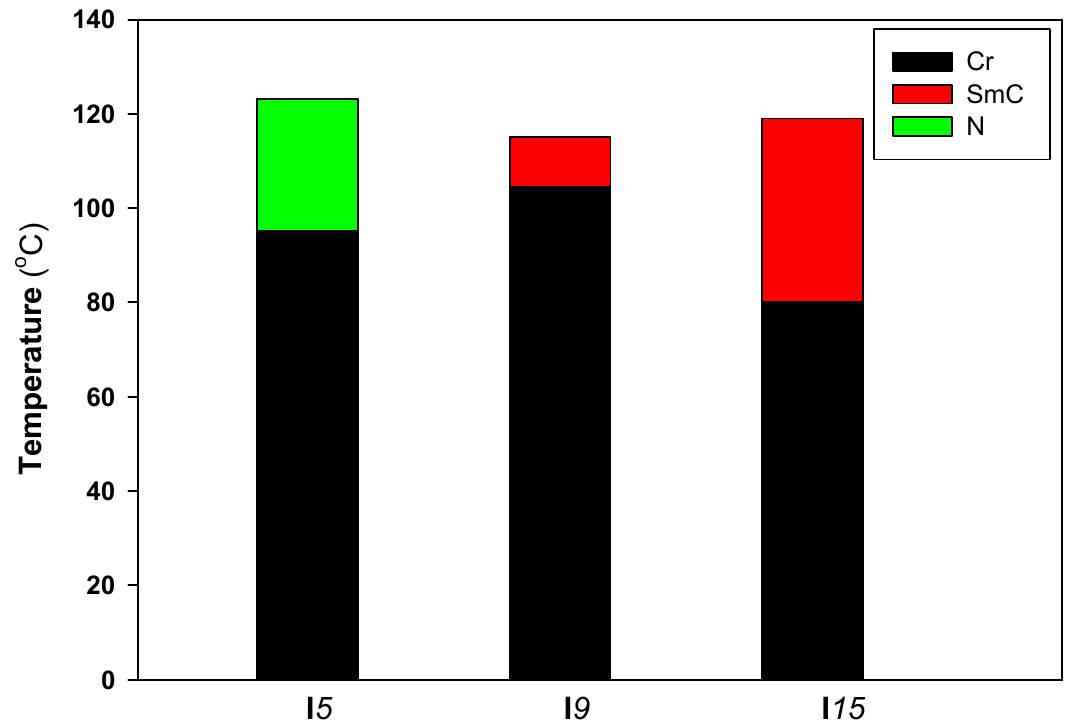
Figure 3. The effect of alkyl chain length on the mesophase behavior of the homologous I n series. The polarity and/or polarizability of the mesogenic core of the molecule plays the most essential role in determining mesophase behavior. The homologue I 5 exhibited the highest mesophase stability (nematic stability = 122.6 ◦ C), while the longer homologues I 9 and I 15 had smectic C stabilities of nearly 115.3 and 118.5 ◦ C, respectively. As indicated by the results, the temperature range of the formed mesophases depended on the molecular anisotropy due to changes in the mesogenic core and geometry of terminal chains of the molecule. The geometrical characteristics, such as dipole moment, polarizability, and molecular shape of the produced I n homologues, had a significant impact on molecular association and led to enhanced formation of the N mesophase for the derivative with the shortest chain ( I 5 ) and the SmC phases for the other longer homologues ( I 9 and I 15 ). Table 1 shows the normalized entropy changes ( ∆ S/R) of the synthesized I n